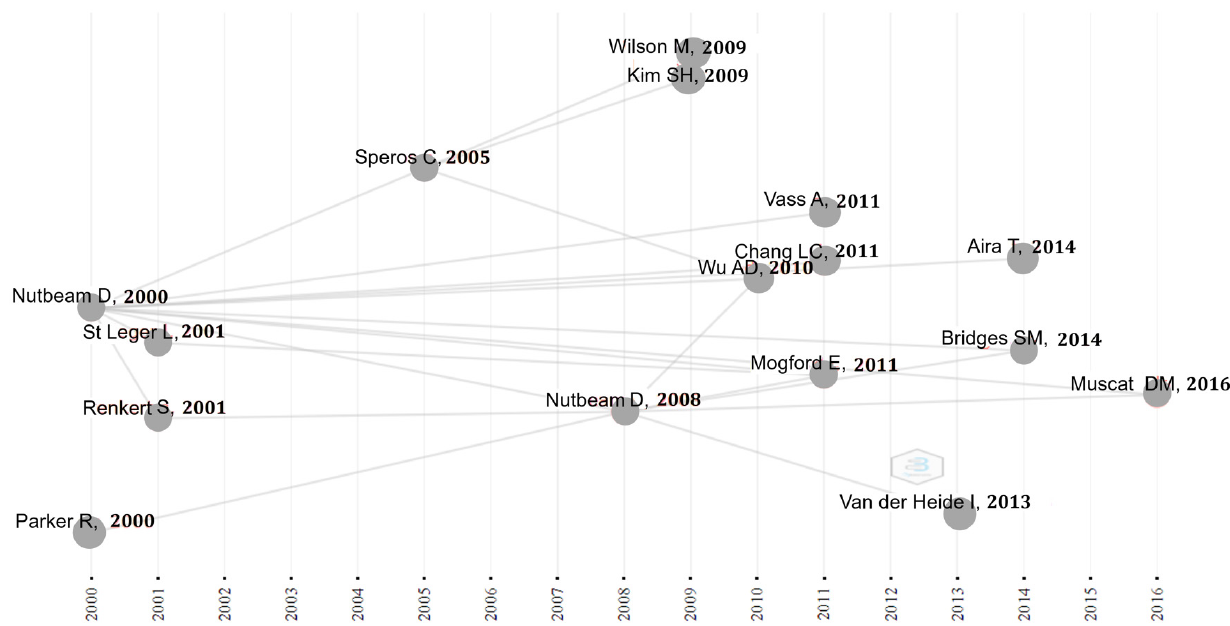
Figure 4. Historical direct citation network.